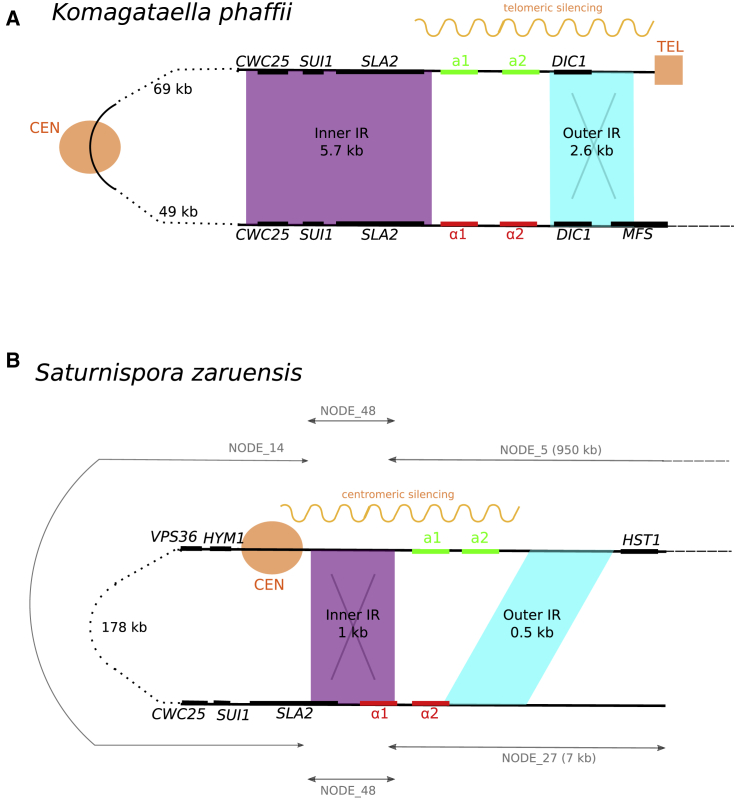
Comparison of MAT Locus Organization in Two Species that Use FF2 Systems of Secondary HomothallismPurple and blue shading indicates inverted repeat (IR) sequences. Centromeres (CEN) and telomeres (TEL) are marked.(A) Organization in Komagataella phaffii [13, 27]. Recombination in the outer IR (blue) is known to move the telomere from beside MATa genes to beside MATα genes, repressing their transcription.(B) Organization in Saturnispora zaruensis, inferred from the scaffolds (nodes) in its genome assembly. Recombination between the two copies of the inner IR (purple) is inferred to move the centromere from beside MATa genes to beside MATα genes, repressing their transcription. The total length of the region between the inner IRs is 194 kb.